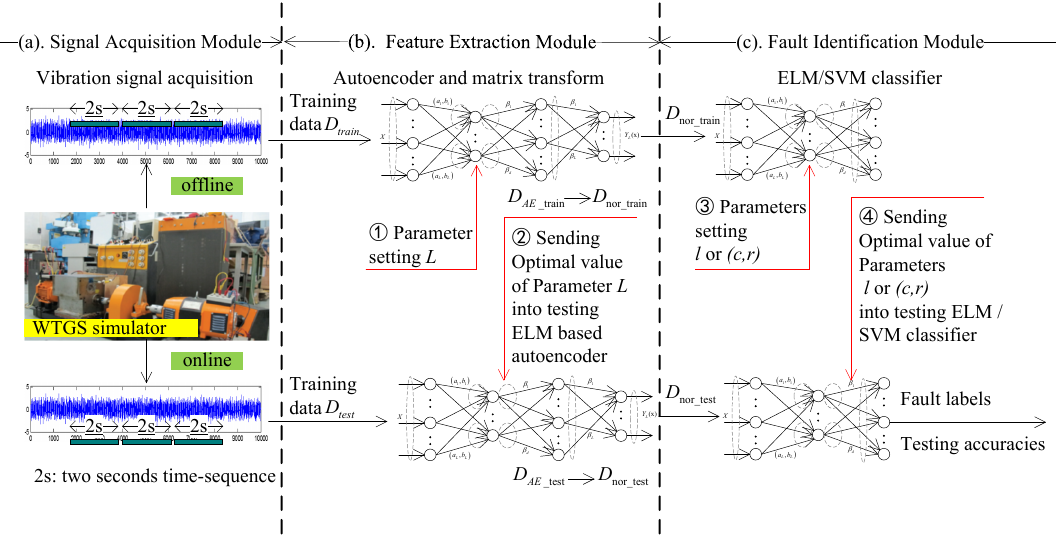
Figure 4. The proposed real-time fault diagnostic scheme for